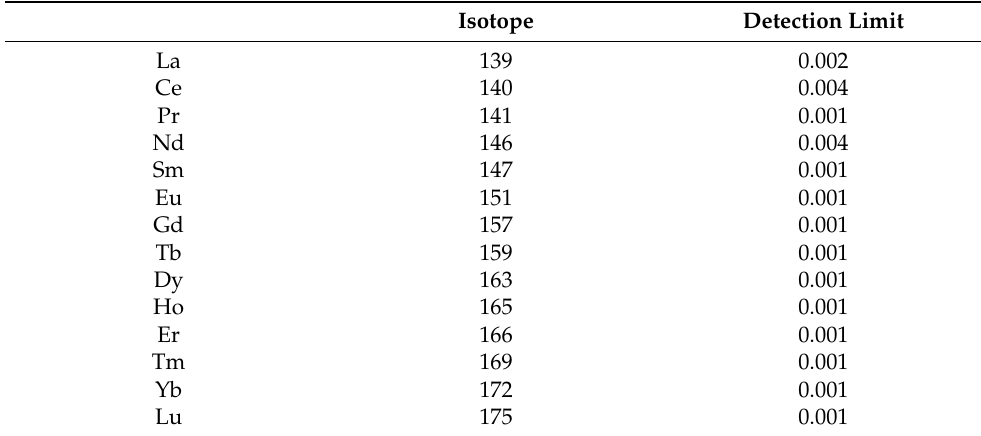
Table 1. Selected REE isotopes and their detection limits ( µ g/g).